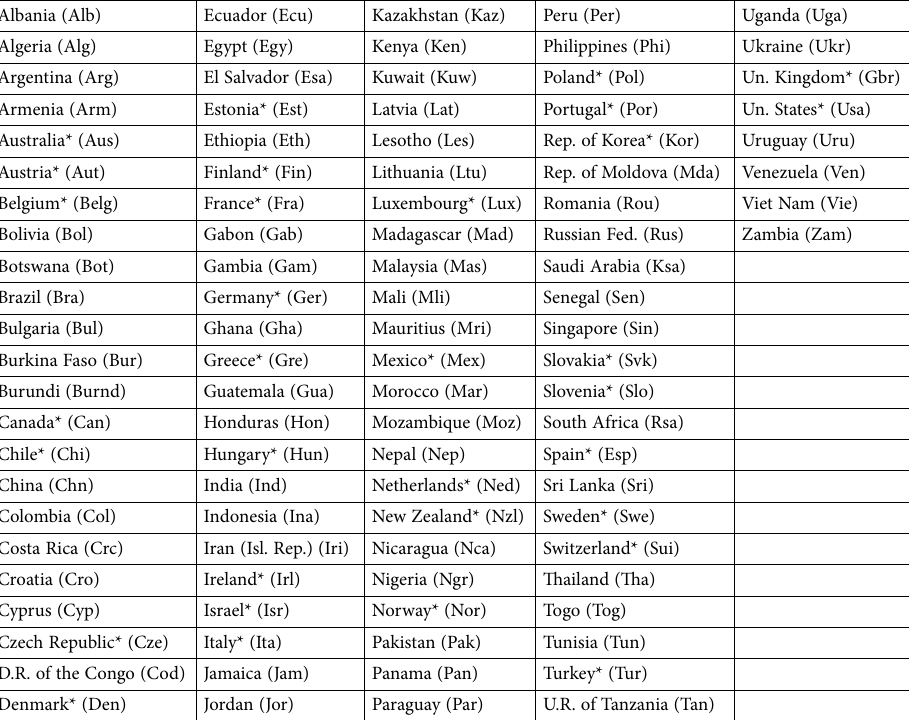
Table A.2. List of Countries Analysed (source: By authors. *OECD